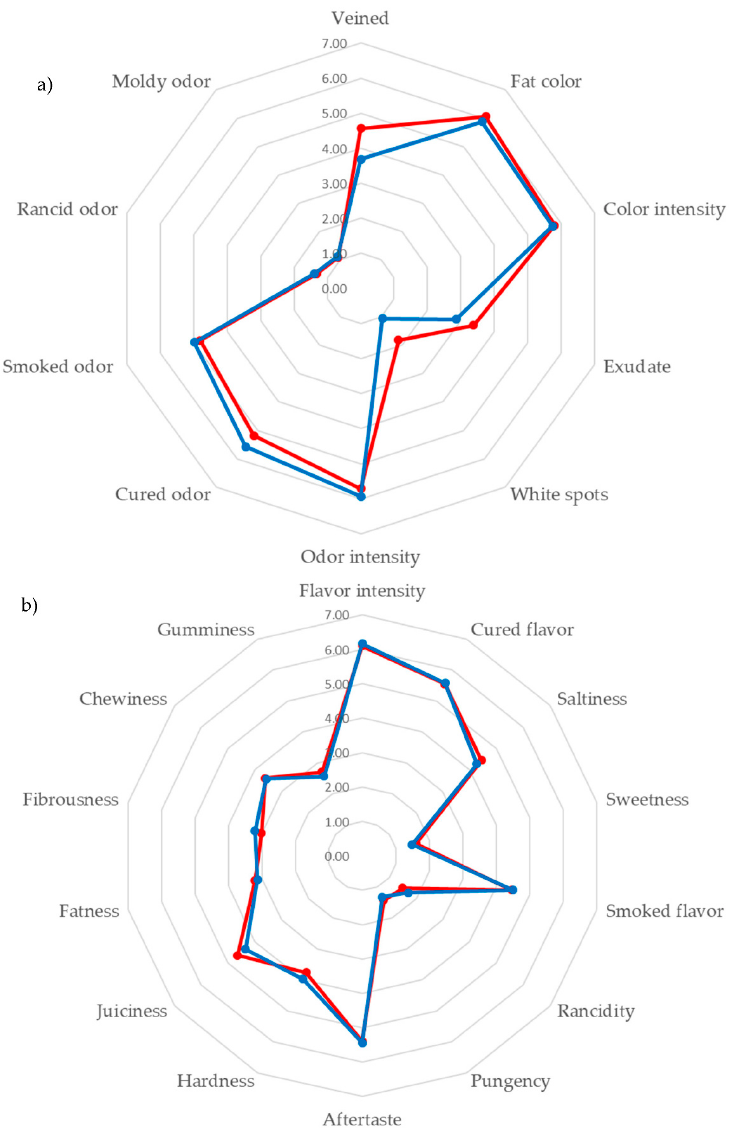
Figure 2. The mean values of ( a ) the appearance and odor attributes and ( b ) flavor and texture attributes of the Protected Geographical Indication (PGI) (red) and non-PGI (blue) samples.